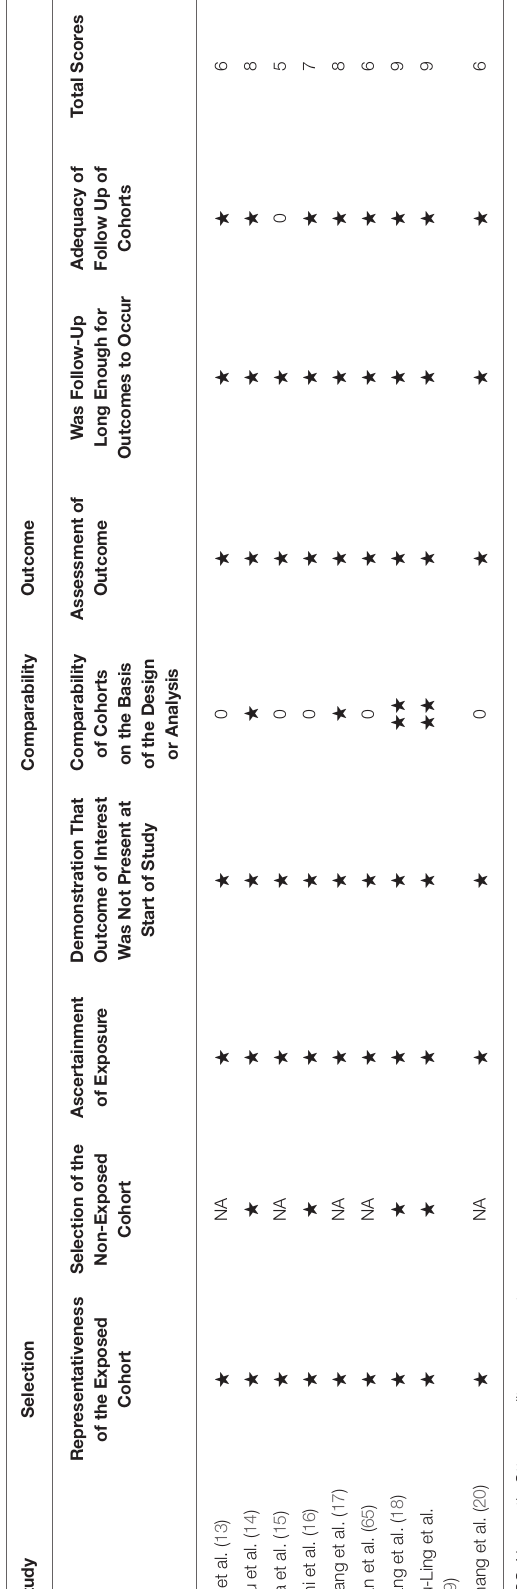
TABLE 3 | Scoring scale for “Comparability” column in Newcastle-Ottawa